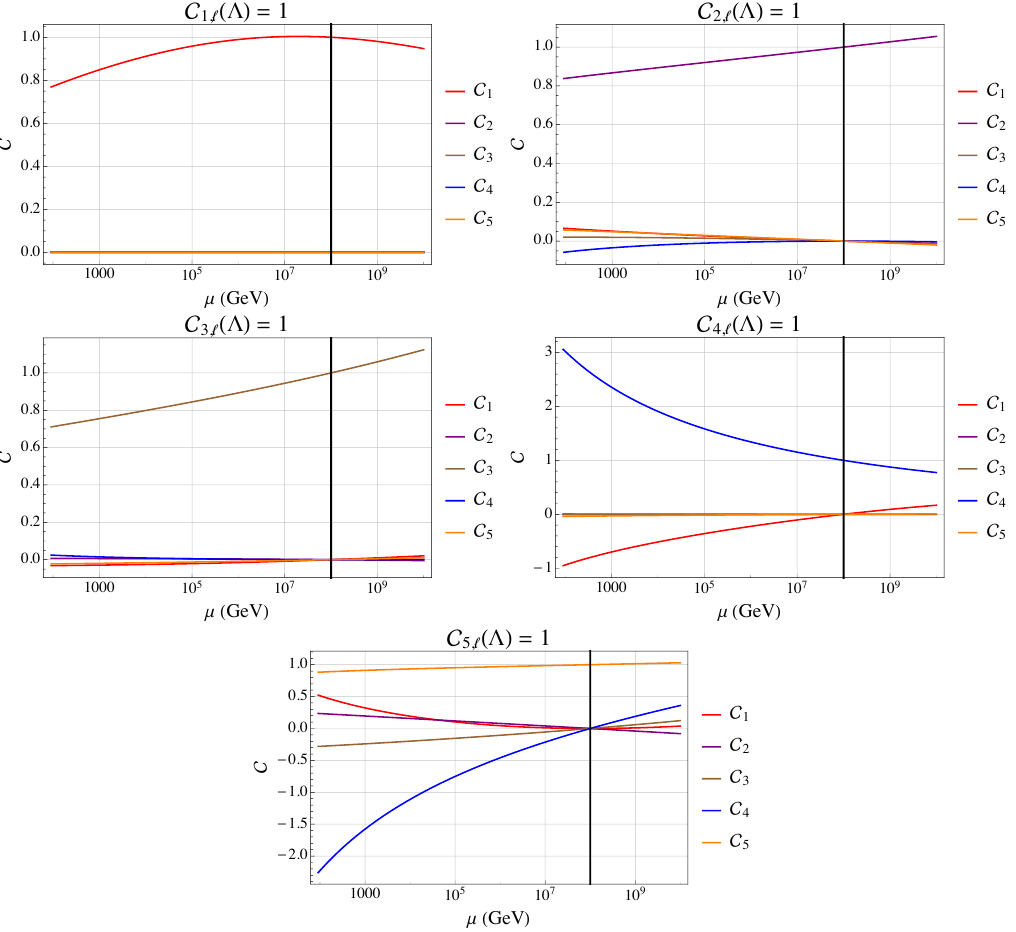
Figure 1 . Running for the five different initial conditions C i,‘ (Λ) = 1 . The color coding for each Wilson coefficient is the same in each plot and shown in the legend on the plot side. The vertical black line is at Λ = 10 8